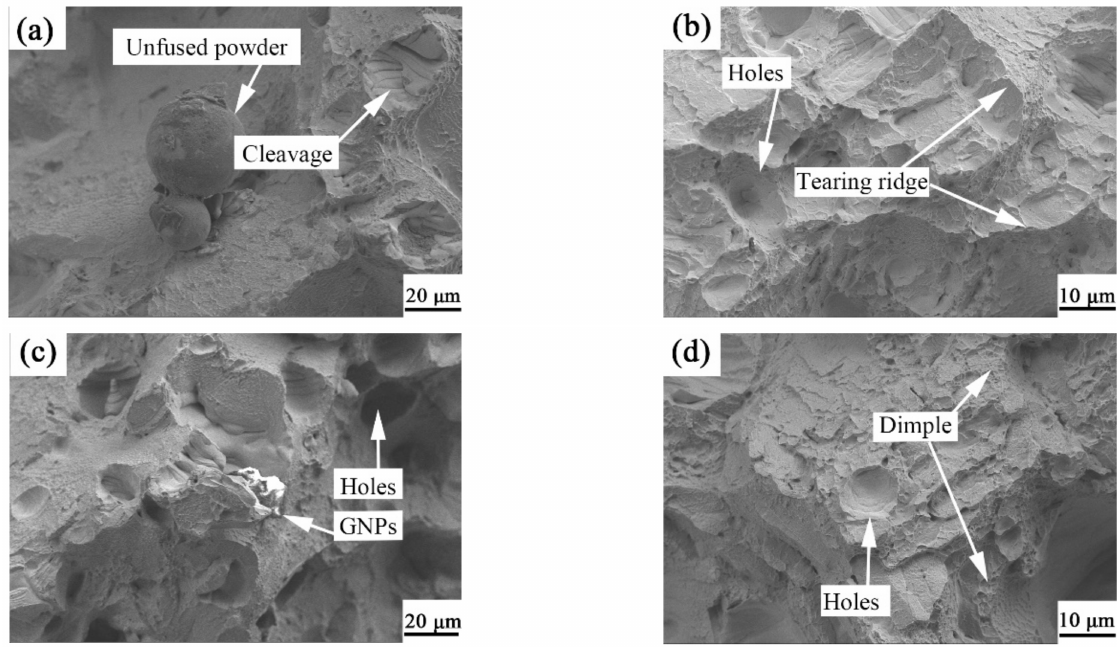
Figure 10. Fracture topography of stretched parts: ( a , b ) TC11 titanium alloy; ( c , d ) GNPs/TC11 titanium matrix